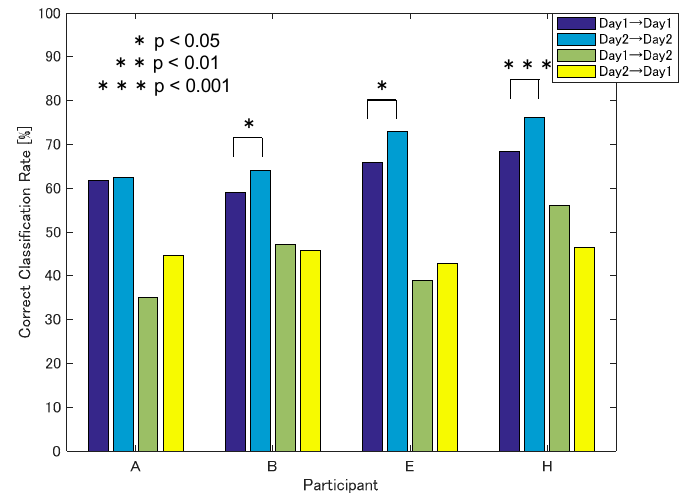
Figure 11. Comparison of mean correct rates of each classification scenario (17 Movements). (*) represents p < 0.05, (**) represents p < 0.01 and (***) represents p < 0.001.